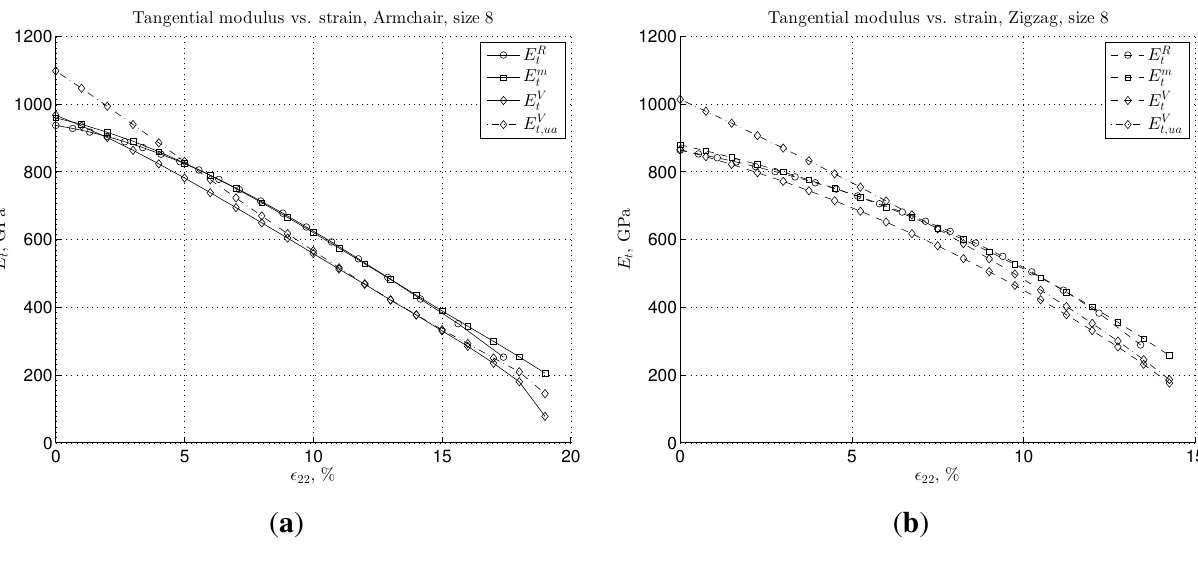
Figure 7. Tangential modulus-strain dependence for large strain using the Morse interaction shown for: ( a ) armchair and ( b ) zigzag graphene sample of the size of